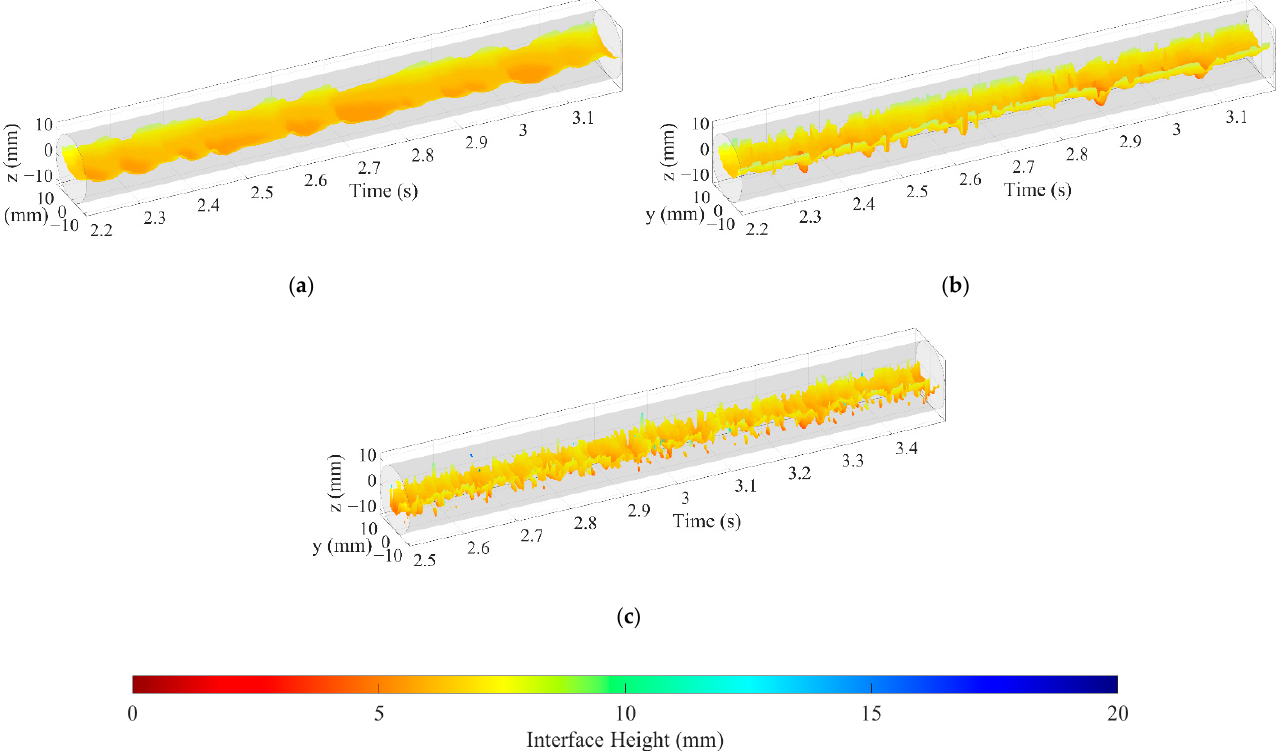
Figure 14. Extraction result of oil–water interfaces and droplets (0°): ( a ) U sw = 0.184 m/s, U so = 0.162 m/s, ST; ( b ) U sw = 0.368 m/s, U so = 0.236 m/s, ST&MI; ( c ) U sw = 0.737 m/s, U so = 0.552 m/s, D W/O&D O/W.